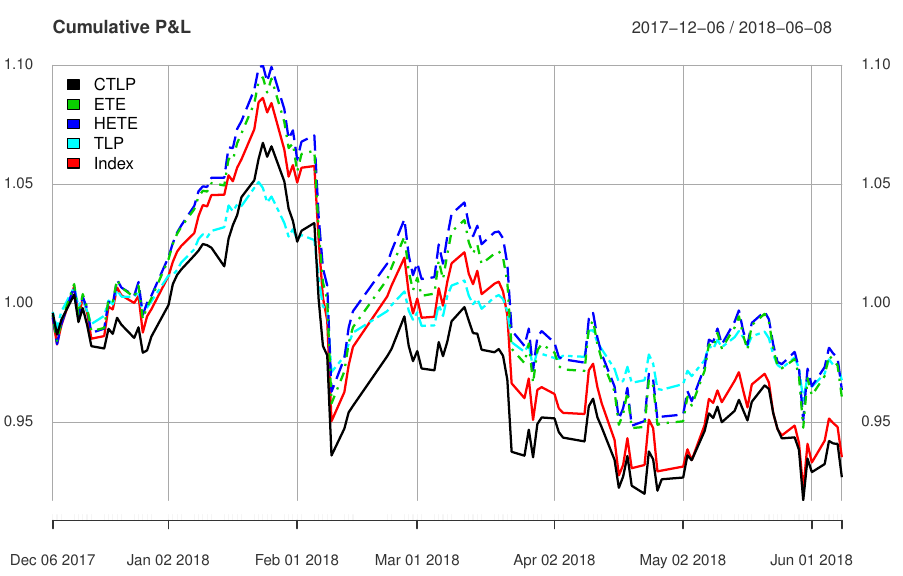
Figure 1. The cumulative profit and loss of portfolios built by different methods and the index in